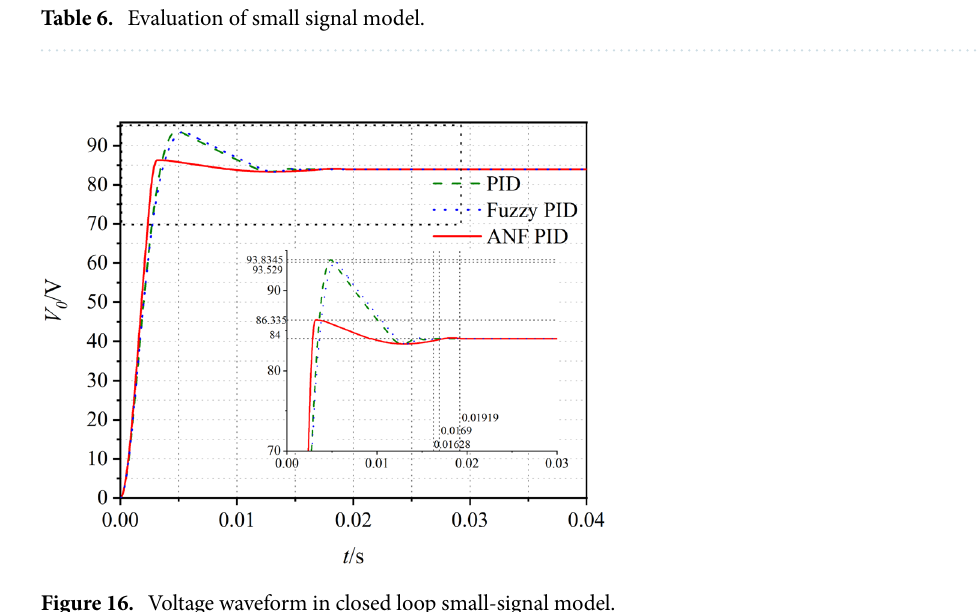
Figure 16. Voltage waveform in closed loop small-signal